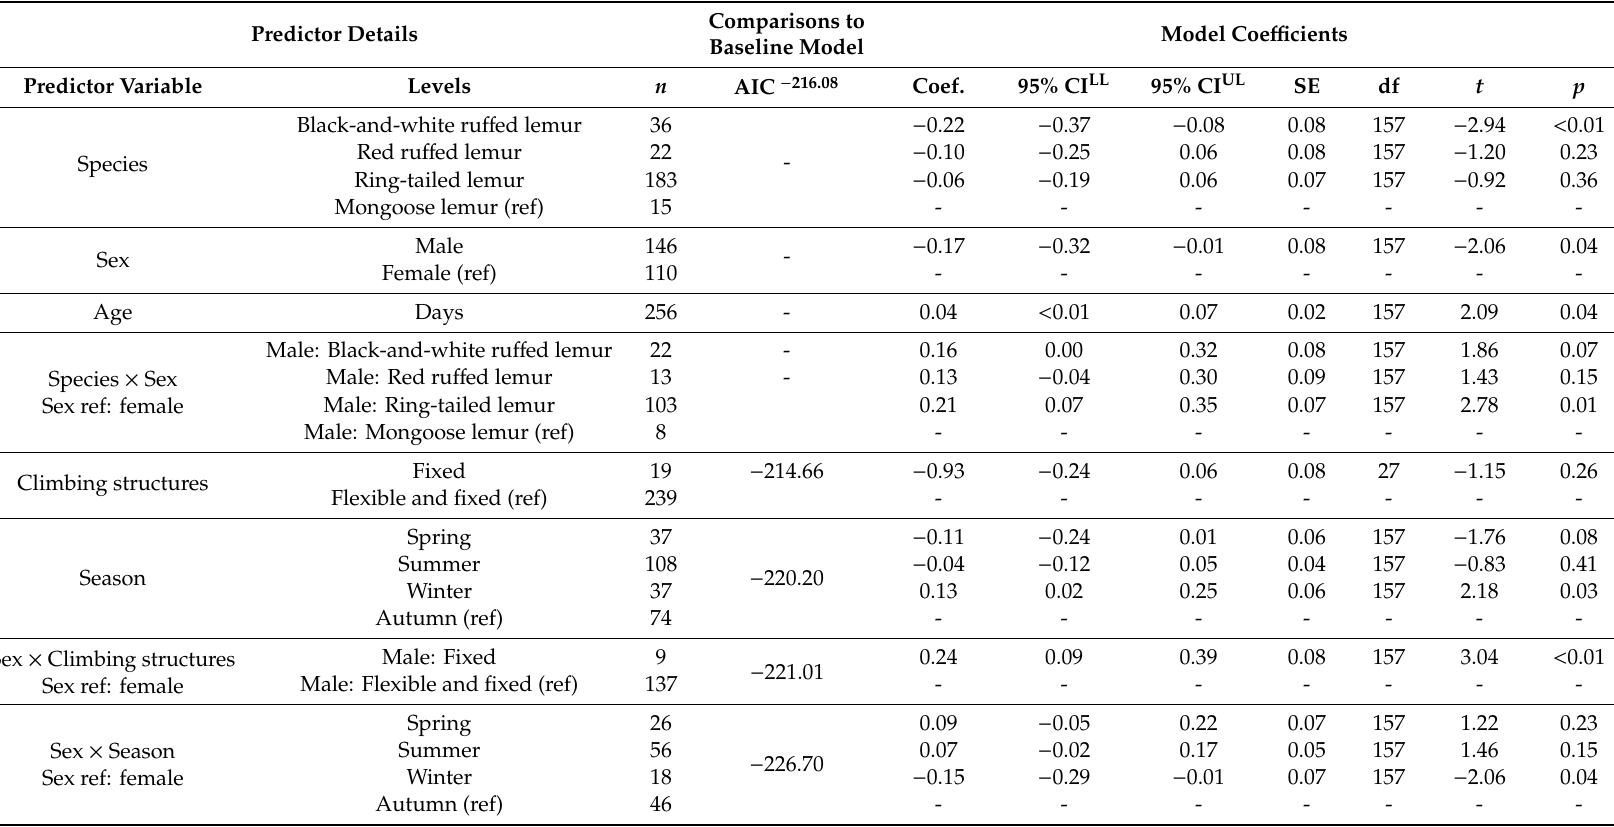
Table 5. Final model of predictors that explain relative body mass. Random e ff ects were ‘enclosure’ nested in ‘zoo’. For each predictor, varying intercepts but common slopes were found to be the best fit to the data. n = number of animals. AIC − 216.08 = AIC value of the baseline model (the first four predictors are the baseline model itself, hence they do not have AIC values). Coef. = coe ffi cient. SE = standard error. df = degrees of freedom. 95% CI LL = lower 95% confidence interval of